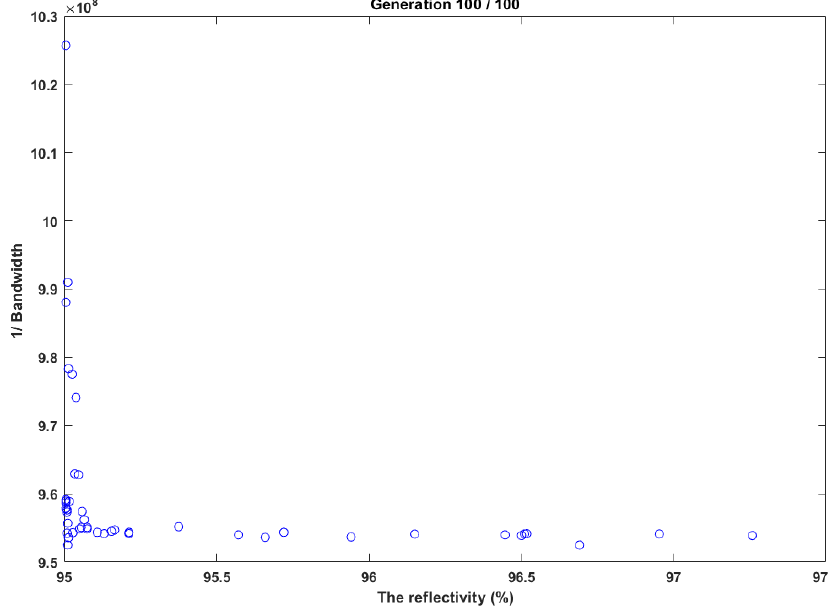
Figure 4. NSGA-II test case for high reflectivity and narrow bandwidth.